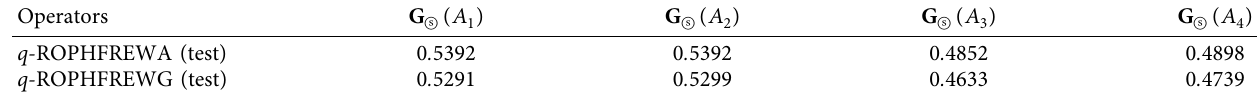
Table 13: Score values.